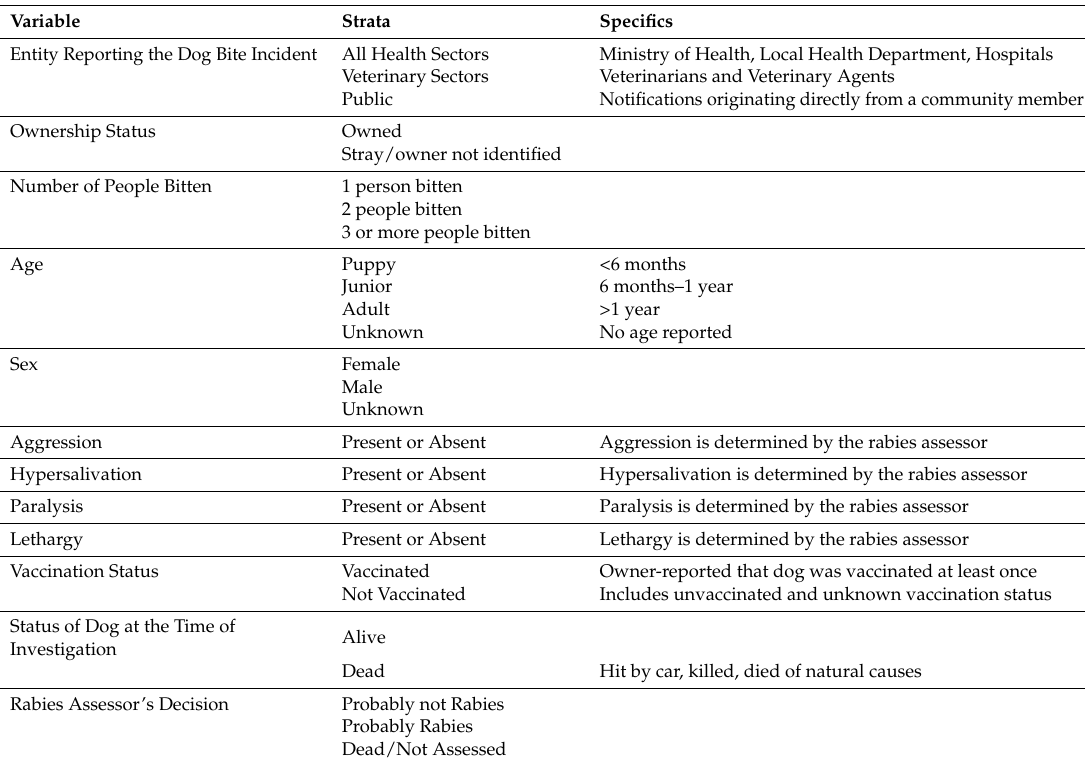
Table 1. Summary of